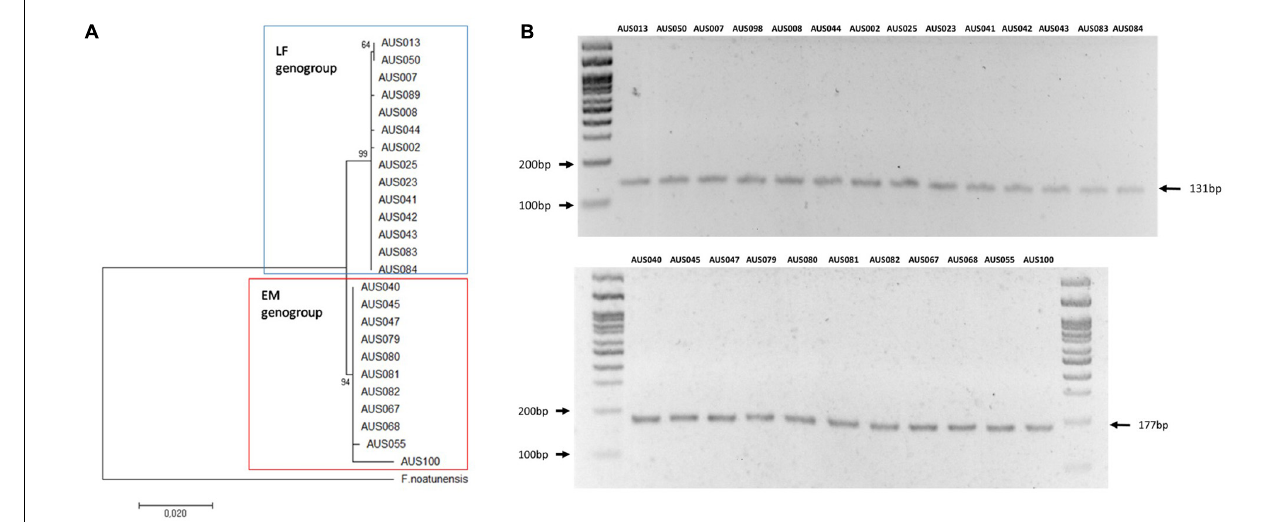
FIGURE 6 | Comparative result of Multiplex-1 prototype and phylogenetic analysis of 16s rRNA gene sequences. (A) Molecular phylogenetic analysis using the maximum likelihood method. The Kimura 2-parameter model was used and Neighbor-Joining with 1,000 bootstraps. The 16S rRNA gene sequence of F . noatunensis was used as an outgroup. (B) Multiplex-1 prototype; upper and bottom panels depict isolates of LF-89 and EM-90 genogroups,